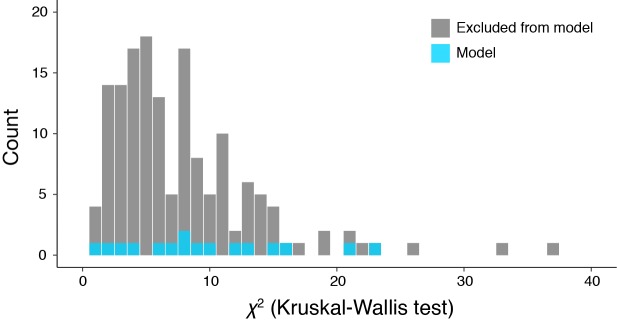
Distribution of magnitude of diagnosis effect on connectivity change between the connections in the model and other connections.The horizontal axis shows chi-square values of a Kruskal-Wallis test for each connection. There was no significant difference between the two groups (two-sample Kolmogorov-Smirnov test, p = 0.30).